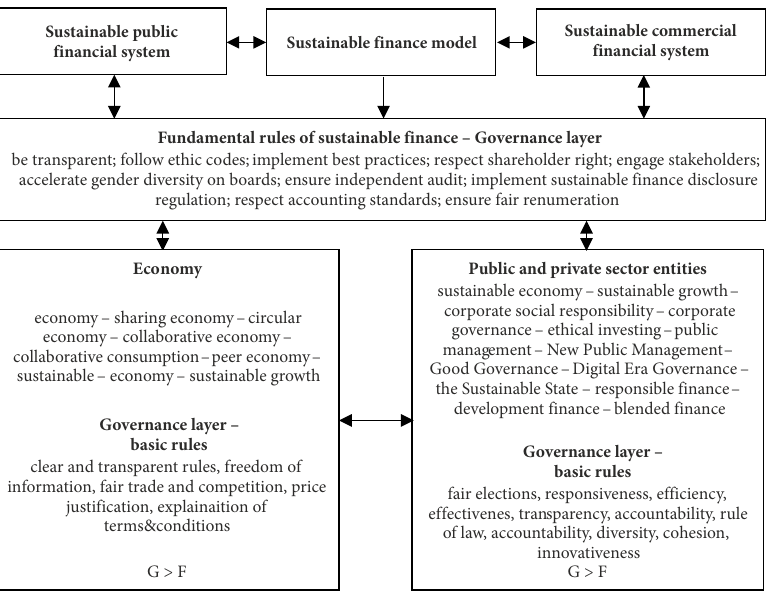
Figure 9. Triple layered sustainable finance model – governance perspective